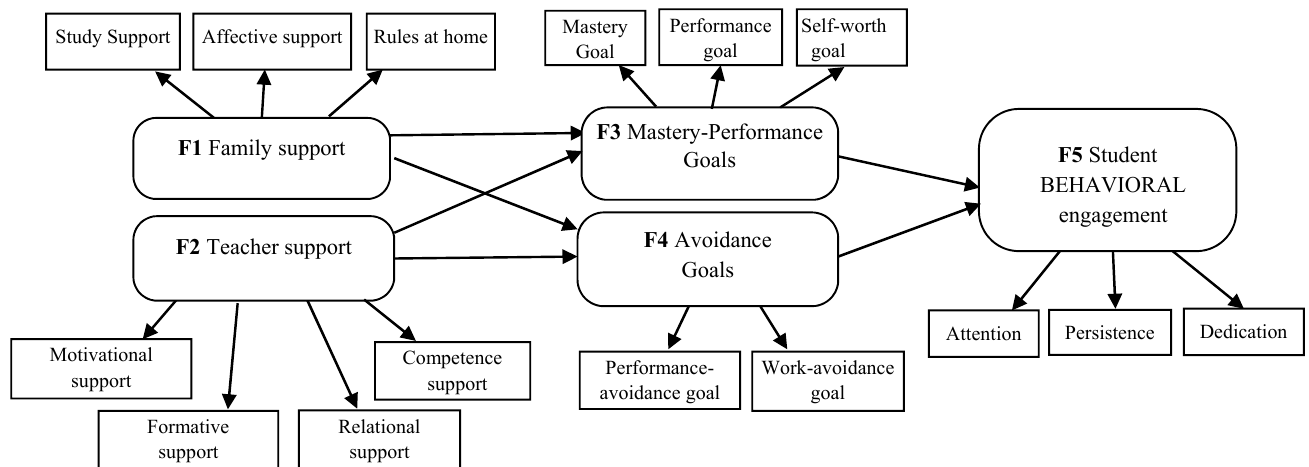
Figure 4. Hypothesized model (M2). Relation among family (Factor 1) and teacher (Factor 2) support, achievement goals (Factor 3, Factor 4), and student behavioral engagement (Factor